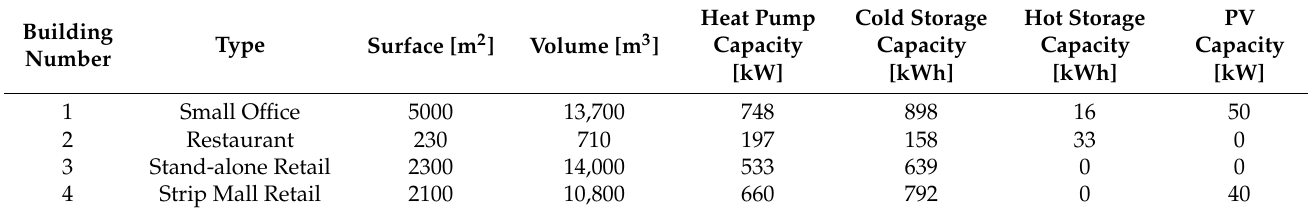
Table 1. Building and energy system properties.